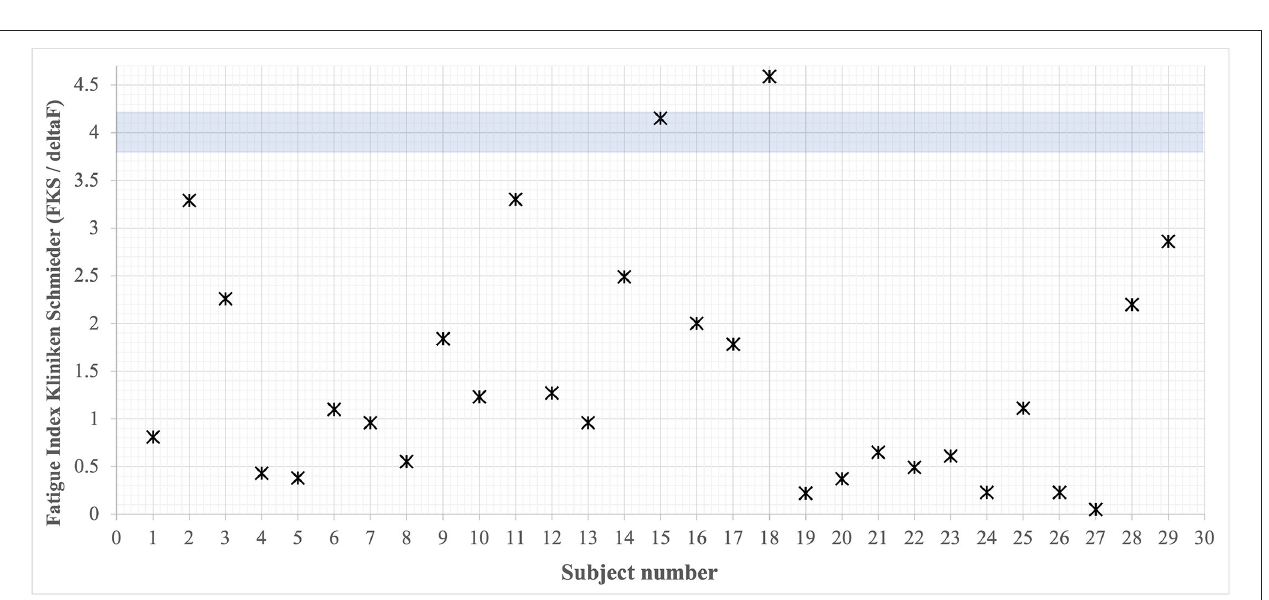
The described motor-related findings are also underlined